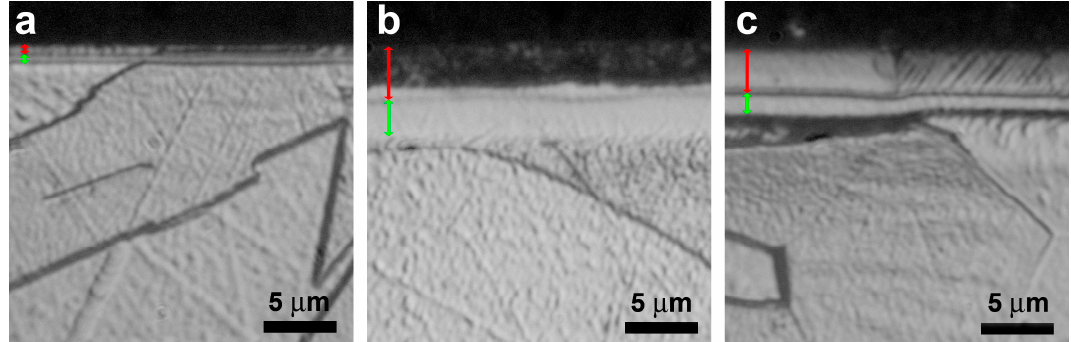
Figure 3. Micrographs of the modified surface layers of Type-A ( a ), Type-B ( b ) and Type-C ( c ) treated samples (etchant: Acetic glyceregia). The red and green markers indicate the outer and inner modified layers, respectively.